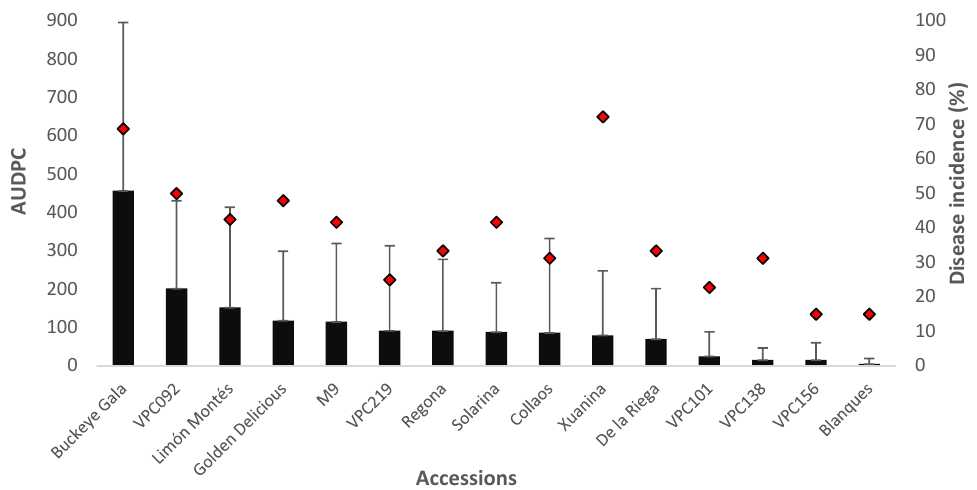
Figure 3. Mean area under disease progress curve (AUDPC; mean ± SD) and disease incidence (pro- portion of infected wounds as a percentage of the number of inoculated wounds) for 1-year-old potted trees inoculated with field-collected inoculum calculated 164 days post-infection. The solid black bars represent AUDPC values whereas the red rhombuses indicate the disease incidence per- centage. Table 3. Results of generalized linear models (GLM) analyses for AUDPC and disease incidence (%) in three artificial inoculation tests. Degrees of freedom (Df) stands for the number of accessions evaluated in each experiment. The letter “n “stands for the number of inoculation points for the AUPDC analysis and the number of inoculated shoots (adult trees test) or potted trees in the disease incidence (%) analysis.